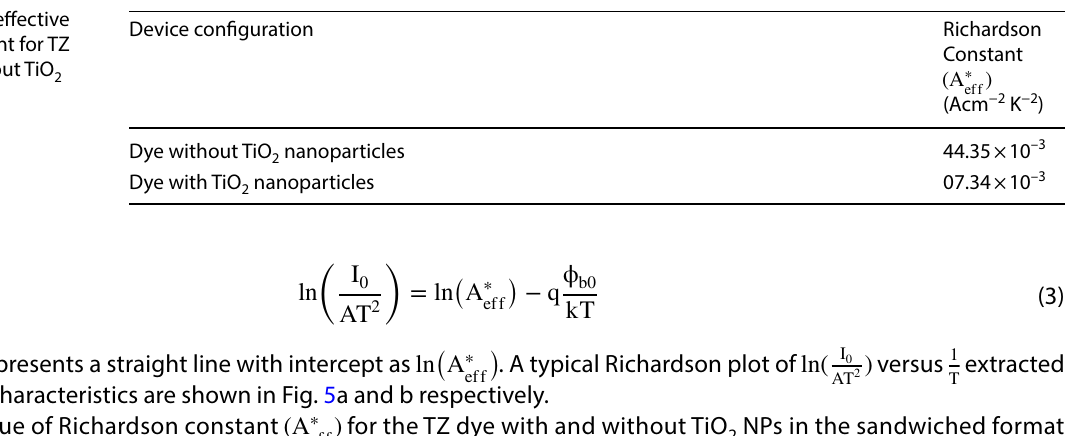
with temperature and b Richardson plot for TZ dye with and without TiO 0